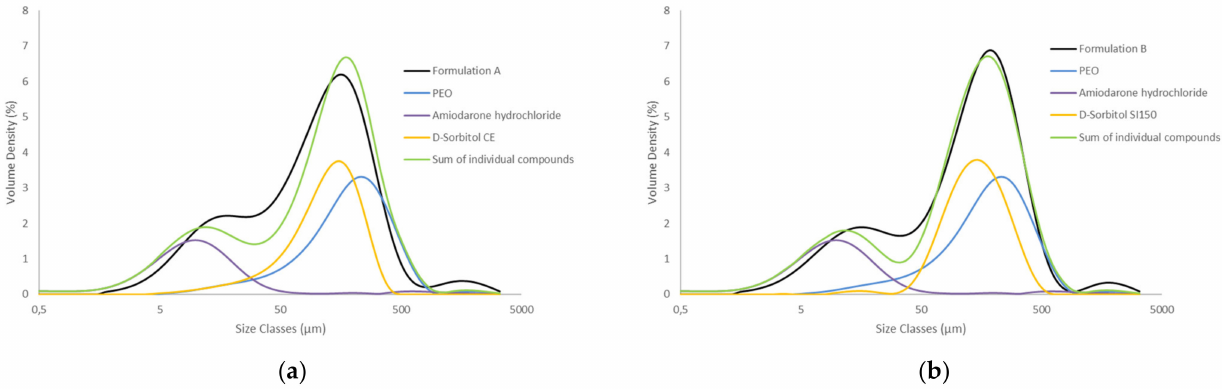
Figure 9. PSD comparison of individual components of the formulation, API, SI150, CE and PEO, the formulation A ( a ) and B ( b ) represented in black after mortar mixing and superposition of individual